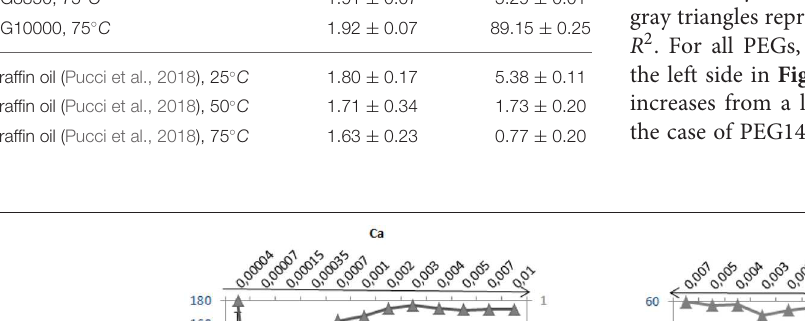
Frontiers in Materials |